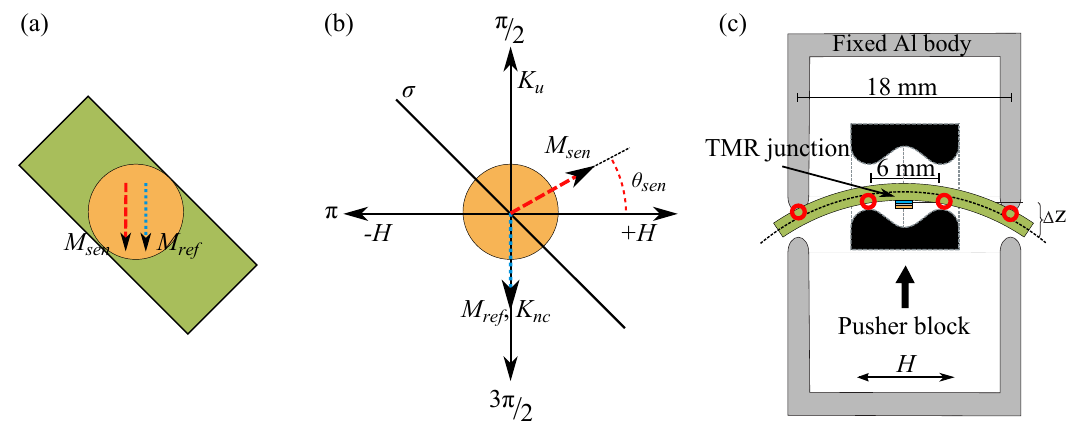
Figure 2. ( a ) The 45 ◦ alignment of the induced anisotropy K u of the sense and reference layers with respect to the length of the cantilever or the stress axis. M sen and M ref of unstrained junctions stay parallel at the zero field due to the Néel coupling ( K nc ) between the two layers; ( b ) Configuration of physical quantities with respect to K u and the stress axis. θ sen denotes the orientation of M sen ; ( c ) Schematic of the four-point bending apparatus. The displacement of the pusher block ∆ Z moves the ceramic pieces (black bodies) and imposes tensile or compressive stress into the TMR junction. The red circles depict the equidistant contact